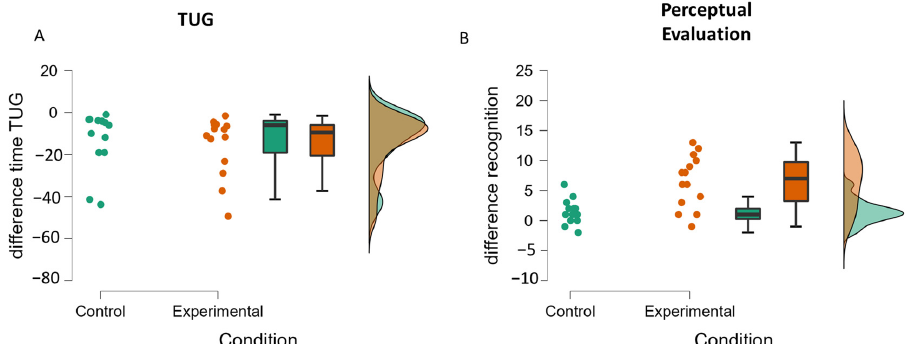
Figure 5. Raincloud plots of the difference between pre-test and post-test for the TUG ( A ) and the perceptual evaluation ( B ) for the control and the experimental